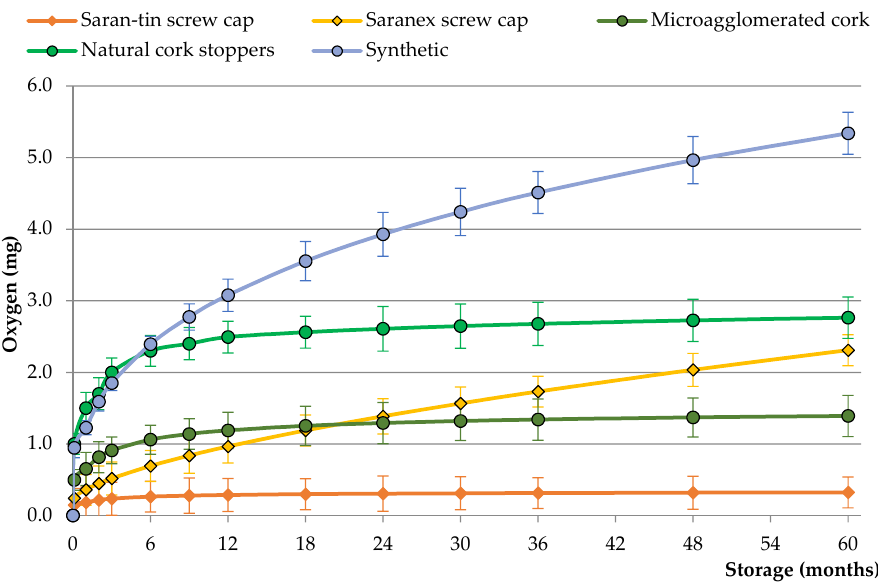
Figure 1. Oxygen ingress through different types of wine closures into bottles during five years of wine storage in a horizontal position.